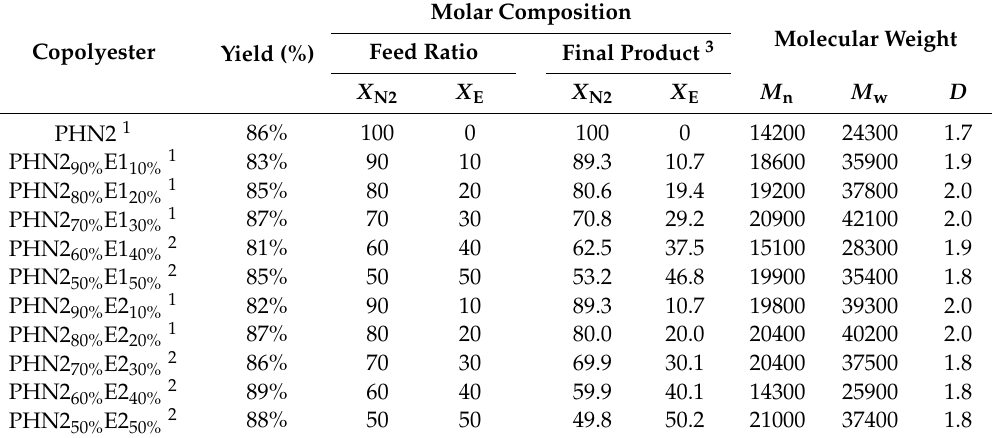
Table 1. Molar composition, molecular weight, polydispersity, isolated yield of the PHN2 1 − x E1 x and PHN2 1 − x E2 x